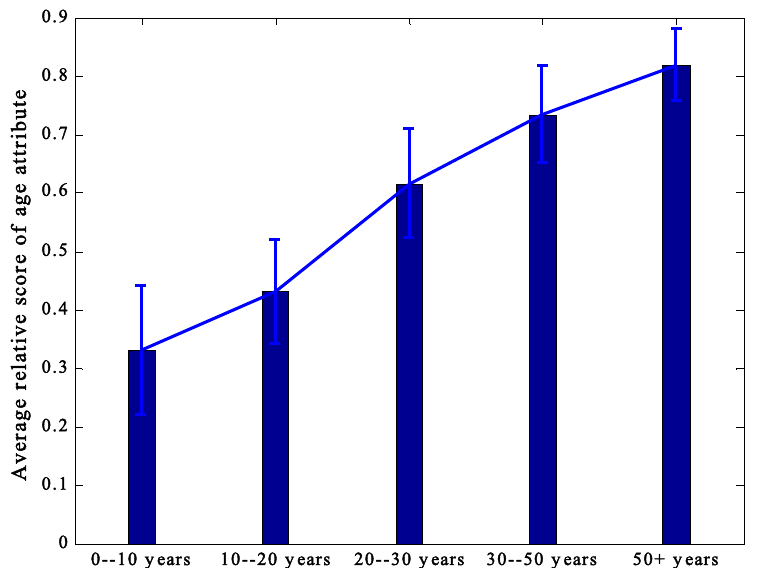
Figure 13. Statistical parameters of the relative score of the age attribute in each predicted successional age group.